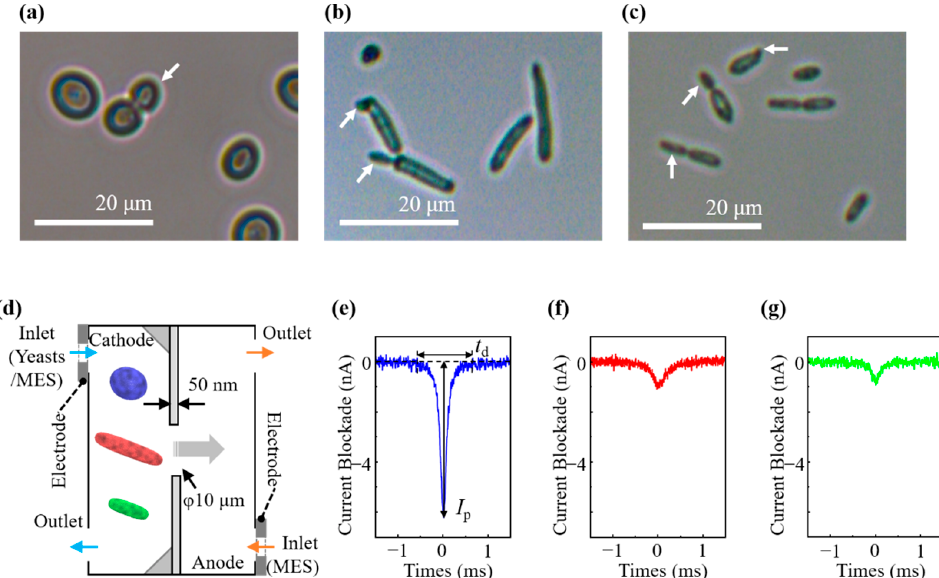
Figure 1. Light microscopic images of ( a ) S. pastorianus , ( b ) D. anomala , and ( c ) D. bruxellensis . Budding is observed in each. Arrows indicate daughter cells. ( d ) Picture of micropore device with a diameter of 10 μ m. A typical waveform of current ionic blockade by RPM was observed for ( e ) S. pastorianus , ( f ) D. anomala , and ( g ) D. bruxellensis .